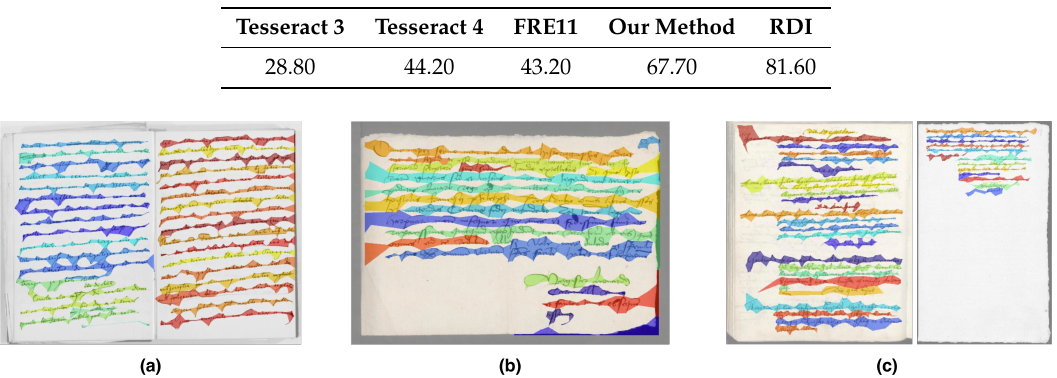
Table 7. RASM2018 competition results in terms of success rate defined by the competition.